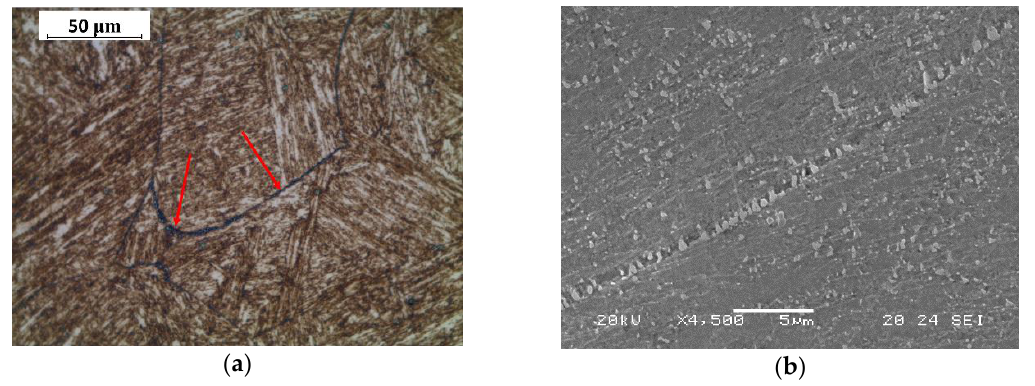
Figure 3. ( a ) Light microscope image (red arrows indicate carbides) and ( b ) SEM image of group O steel microstructure.